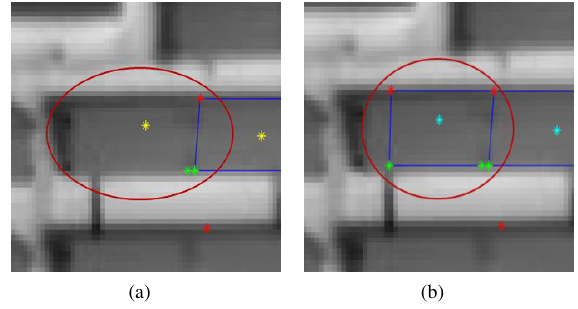
Figure 6. Iterative process case 4: a) twocorners have been de- tected but no Förstner points fulfil the conditions for further cor- ner points. Possible centre points marked in yellow. b) newly added rectangle for the two existing corners and two estimated corner points with verified centre point